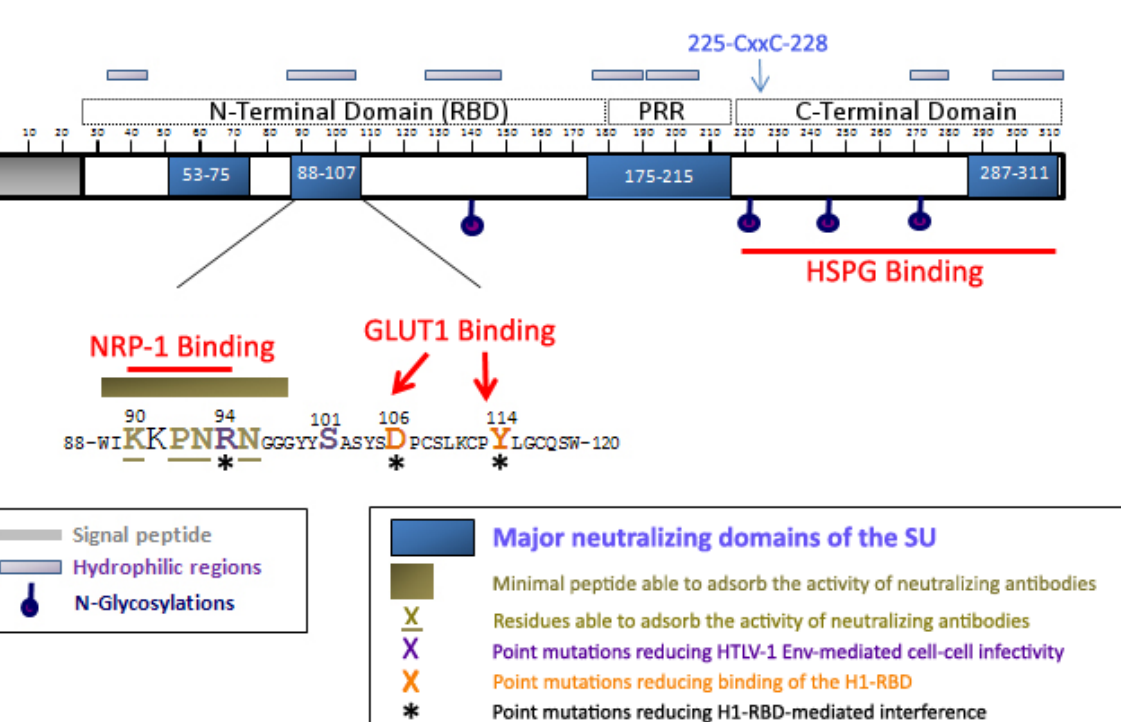
Figure 3. Localization of the neutralizing regions and the domains and residues involved in HSPGs, NRP-1 and GLUT1 binding within the HTLV-1 SU. The 90-94 motif identified